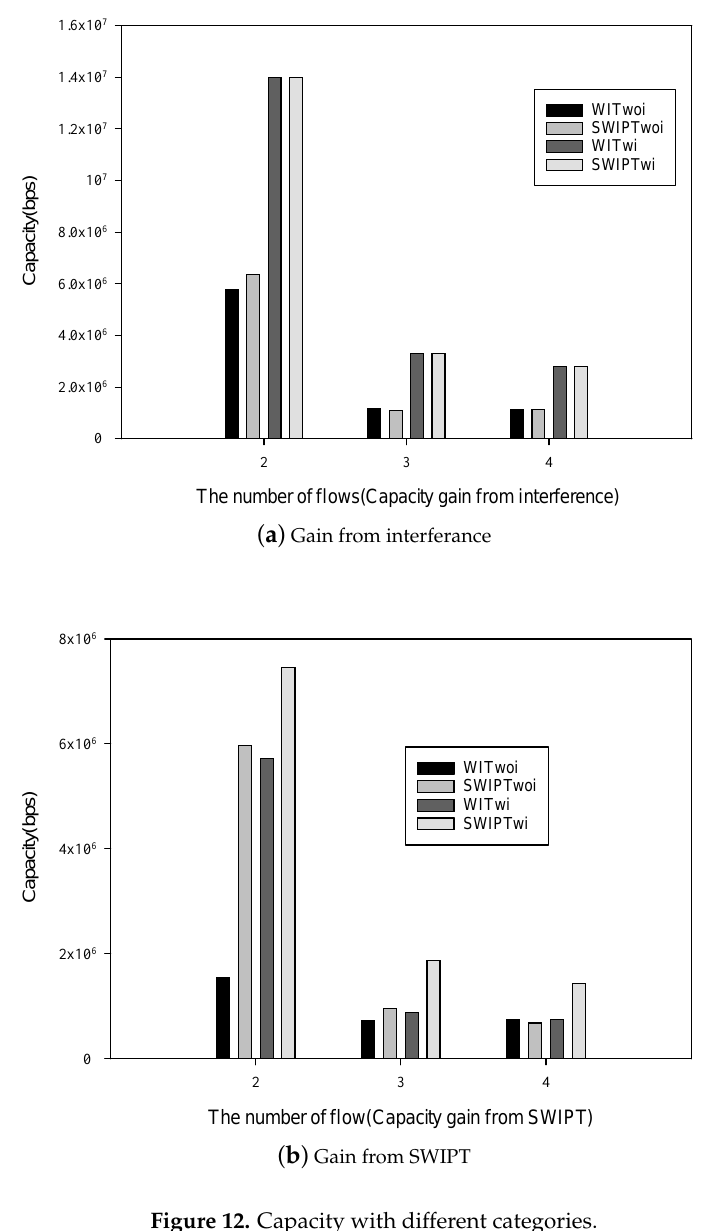
Figure 12. Capacity with different